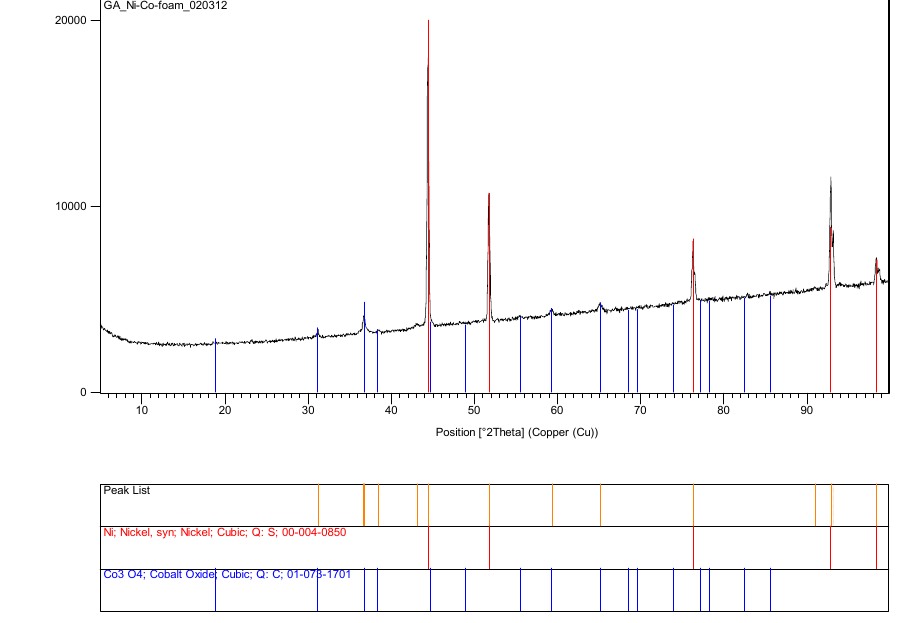
Figure 8. X ‐ ray diffraction pattern of silica supported cobalt catalyst in macro ‐ porous nickel foam.